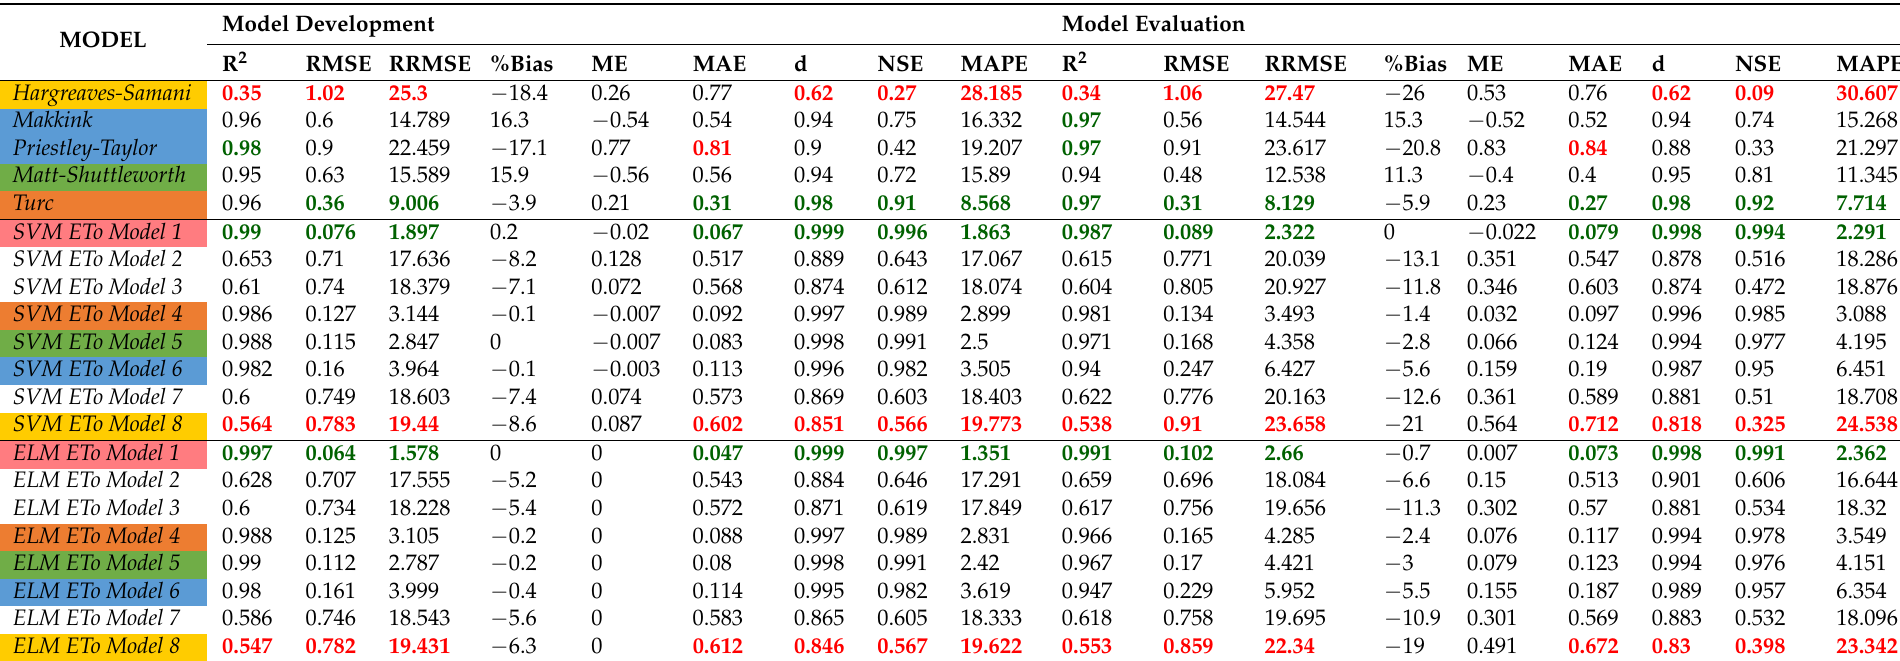
Table 8. Statistical values of empirical and machine learning models used for estimating daily ETo at Alabat Station